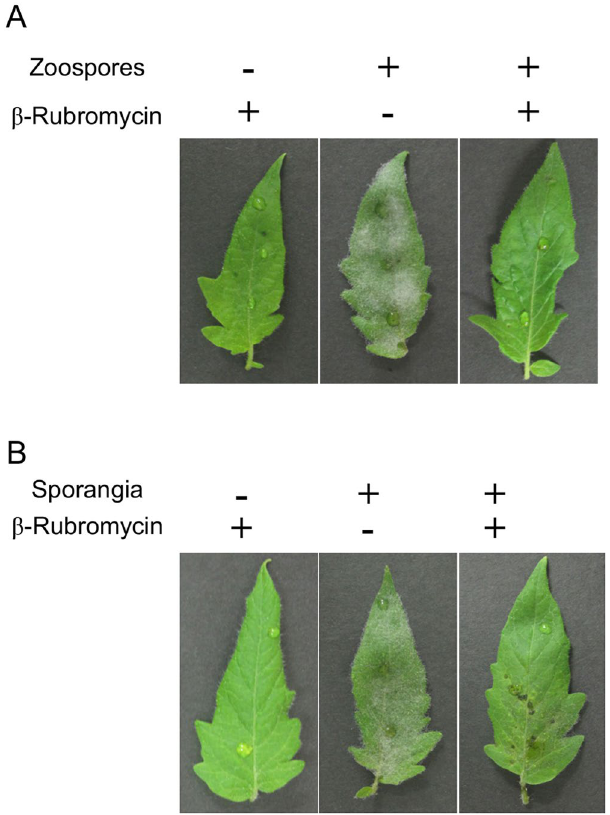
Figure 3. Effect of β-rubromycin on infection and in planta growth of Ph. infestans . ( A ) Tomato leaflets inoculated with zoospores with or without 1.0 mg/L β-rubromycin. The image was taken after 9 days. ( B ) Leaflets infected with a sporangium suspension with or without 1.0 mg/L β-rubromycin that was incubated at 25 °C for 8 h to stimulate direct germination. The image was taken after 9 days. Representative images for three biological replicates are